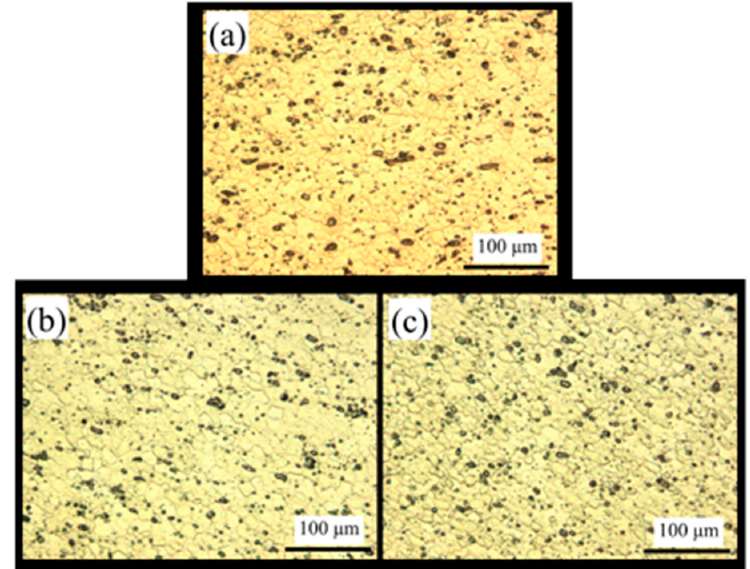
Figure 8. High-magnification of the SZ in PWHT Al6061(T6) samples: ( a ) Sample A-1 (PWHT), ( b ) Sample C-1 (PWHT), and ( c ) Sample C-4 (PWHT). ( b ) Sample C-1 (PWHT), and ( c ) Sample C-4